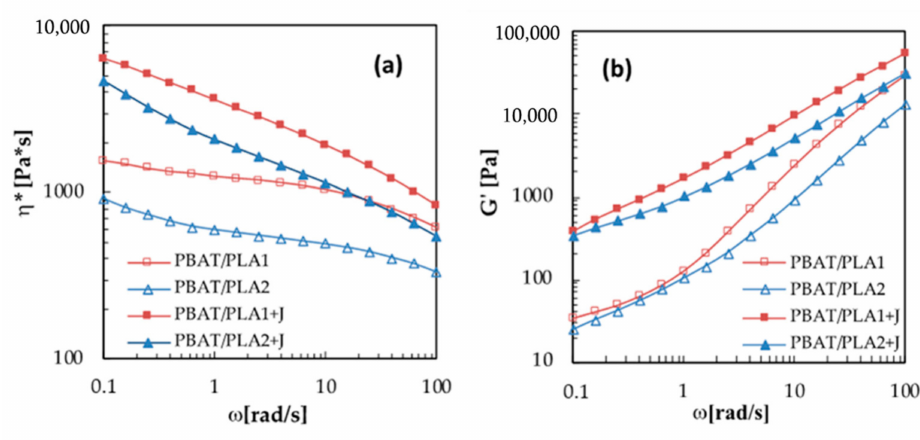
Figure 2. ( a ) Complex viscosity and ( b ) storage modulus of the